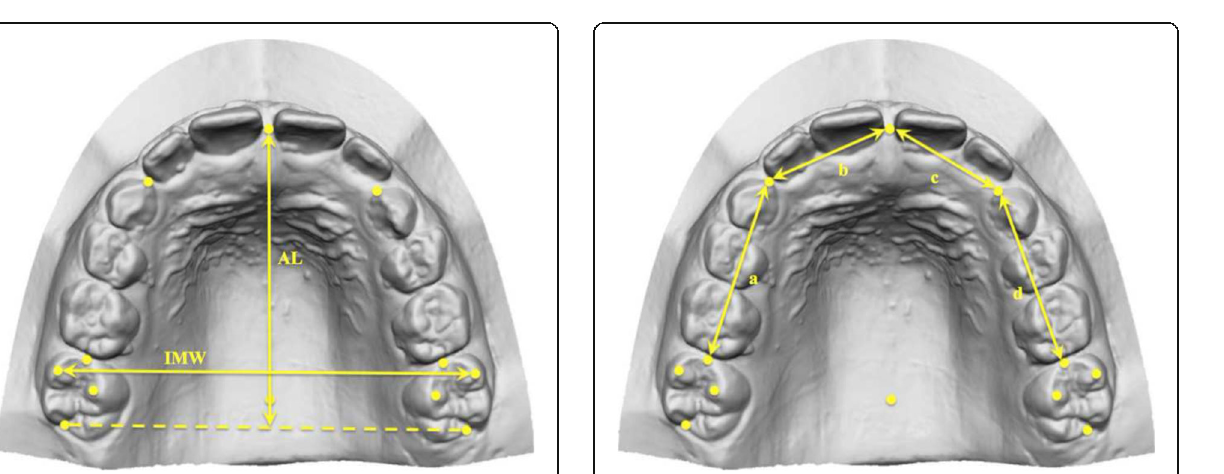
Fig. 4 Representation of the measurements of the intermolar width (IMW) and arch length (AL)